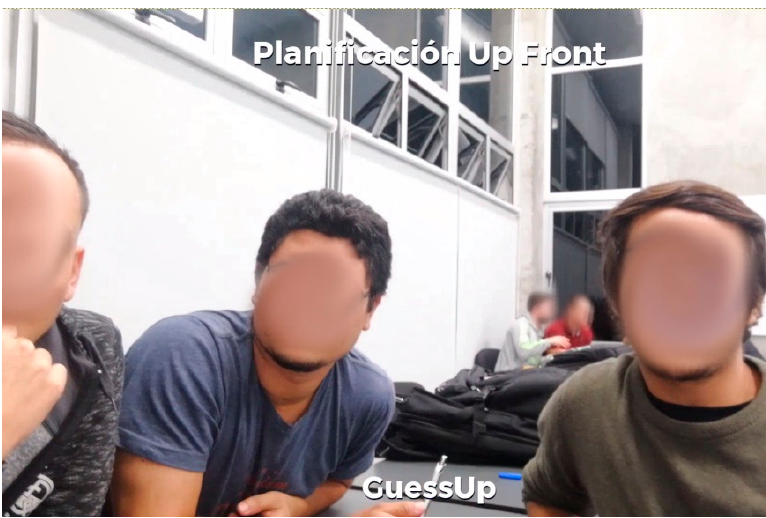
Figure 3. Agile HeadsUp Recording Camera.